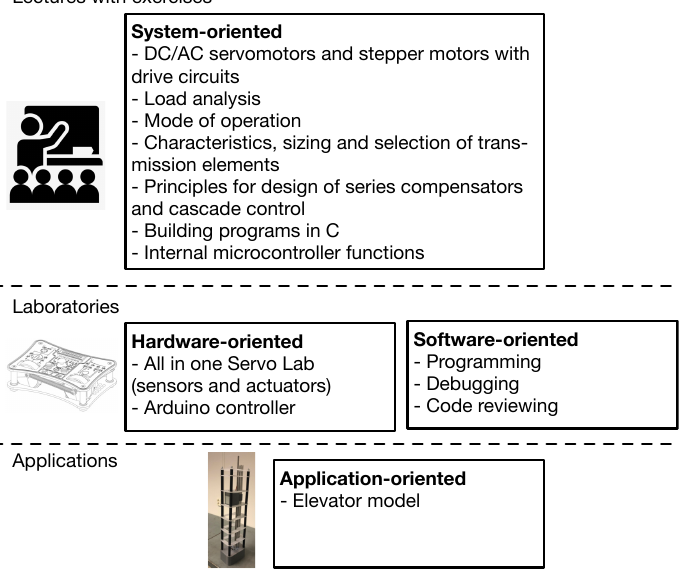
Figure 1. The proposed hands-on organisation of the motion control